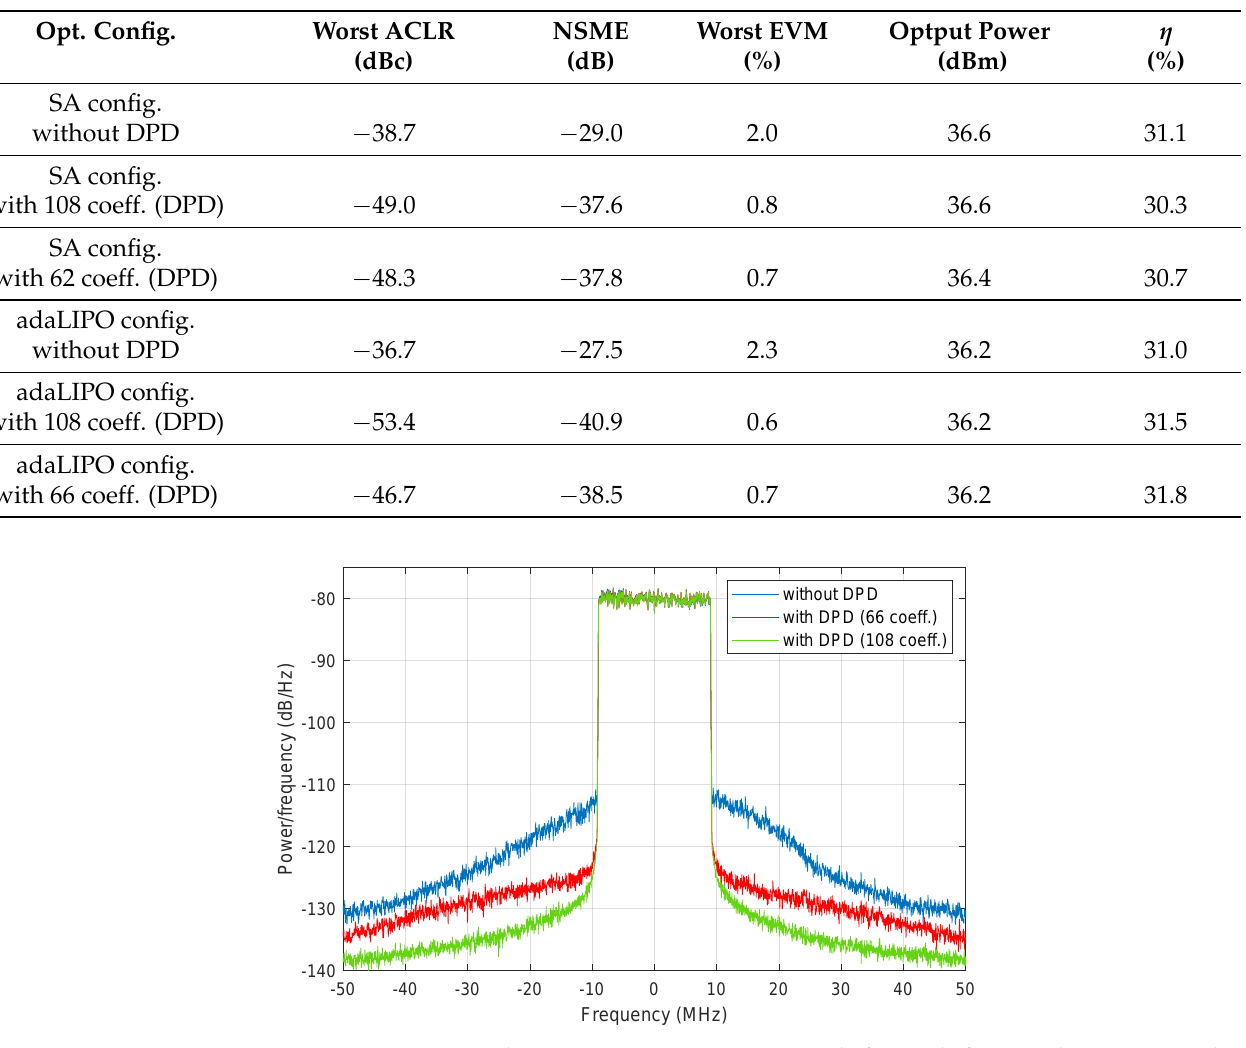
Figure 10. LTE-20 signal test case. Output power spectra before and after DPD linearisation, when considering a DPD behavioural model with 66 and 108 coefficients, respectively, and taking into account the adaLIPO parameters